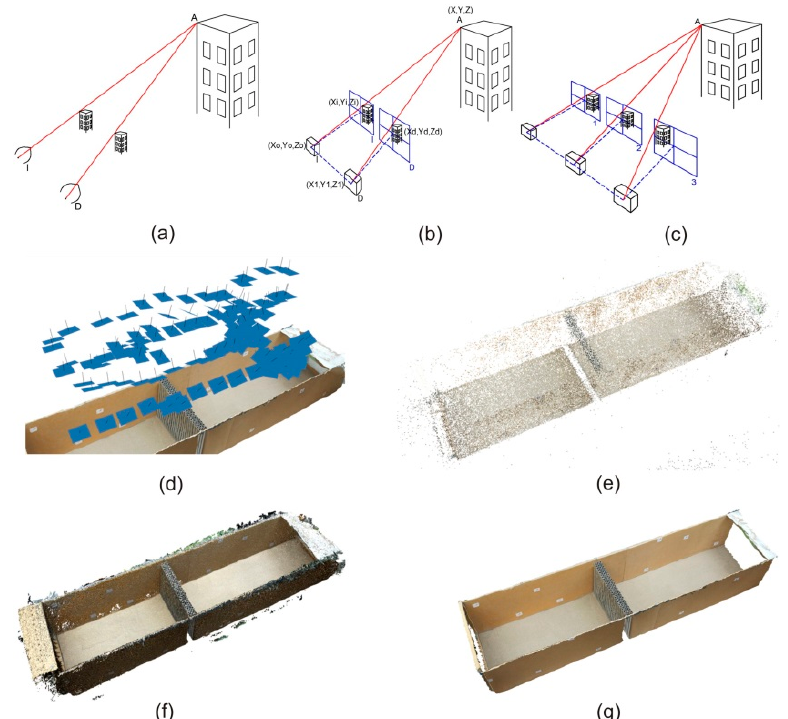
Figure 2. ( a ) Principle of natural stereoscopic vision; ( b ) Mechanism of artificial stereoscopic vision; ( c ) Epipolar trinocular condition for automatic correlation of three images; ( d ) Distribution of the images (in blue) used in one of the measurements of the experimental system. All the images shown meet the corresponding epipolar condition to be placed in the same relative position in which they were taken; ( e ) Result of a three-dimensional scattered point cloud; ( f ) Result of a dense three-dimensional point cloud; ( g ) A three-dimensional photorealistic model obtained after the generation of the triangular mesh and the texturing of its triangles.